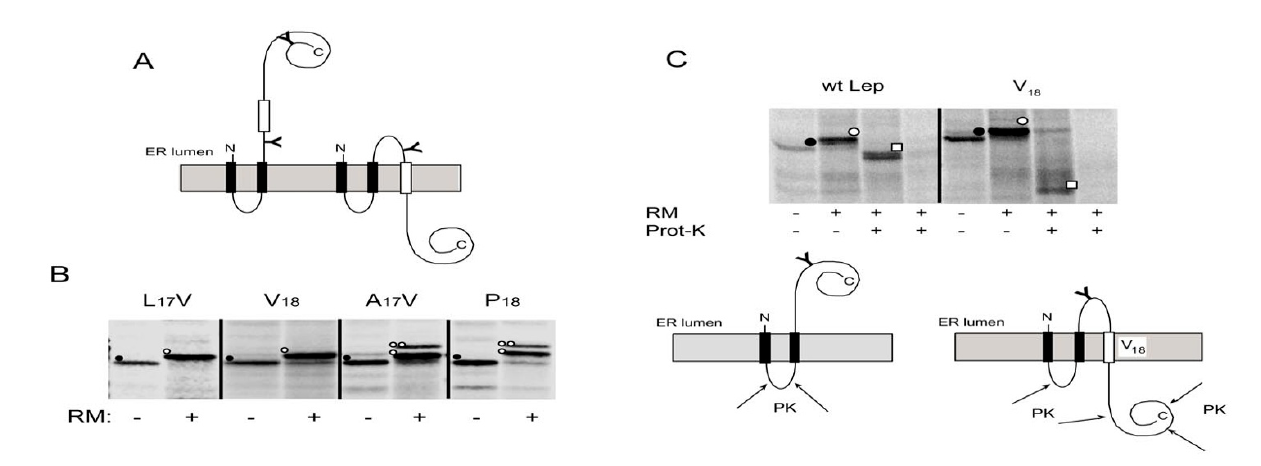
Figure 3 Determination of stop-transfer activity of different full-length constructs. (A) Model segments (white) lacking stop-transfer activity are translocated into the ER lumen and both glycosylation acceptor sites become modified (left). For model segments with stop-transfer function, only the upstream site will become modified (right; Y denotes a glycosylated site, Φ a non-glyco- sylated site). The C-terminal glycosylation site is 6 residues away from the C-terminus of the protein (see Materials and Meth- ods). (B) In vitro translation in the absence (-) and presence (+) of rough dog pancreas microsomes (RM) of constructs with the indicated model segments. Non-glycosylated and mono- and di-glycosylated molecules are indicated by a black dot, a white dot, and two white dots, respectively. (C) Proteinase K (PK) treatment of microsomes carrying in vitro translated wild type Lep (left panel) or the full-length V 18 construct (right panel). The detergent Triton X-100 was included to dissolve the microsomal membrane in lanes 4 and 8. Non-glycosylated and glycosylated molecules are indicated by a black dot and a white dot, respec- tively. Protease-protected fragments are indicated by a white